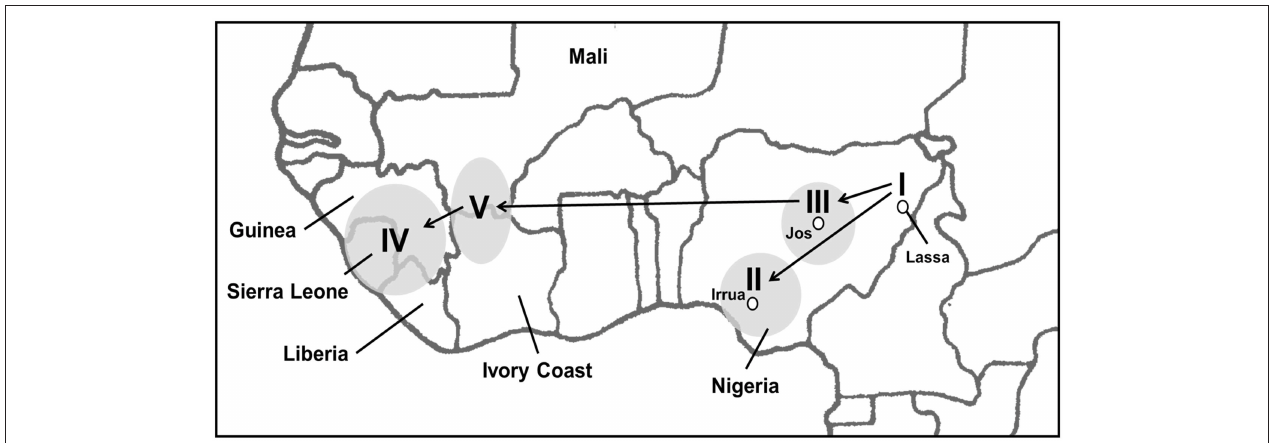
FIGURE 3 | Map of LASV movement across West Africa. Based on the phylogenetic data, LASV has gradually spread west, beginning in Eastern Nigeria. Ehichioya et al. has previously illustrated the movement of LASV within Nigeria (Ehichioya et al., 2011). The isolates of lineage V and the BA366 Liberian isolate share a more direct common ancestor with lineage III than the Sierra Leone Isolates share with lineage III isolates. This suggests that the virus was likely present in Mali, the Ivory Coast, and Liberia prior to establishing itself in Sierra Leone. The areas from which the isolates were collected are shaded in